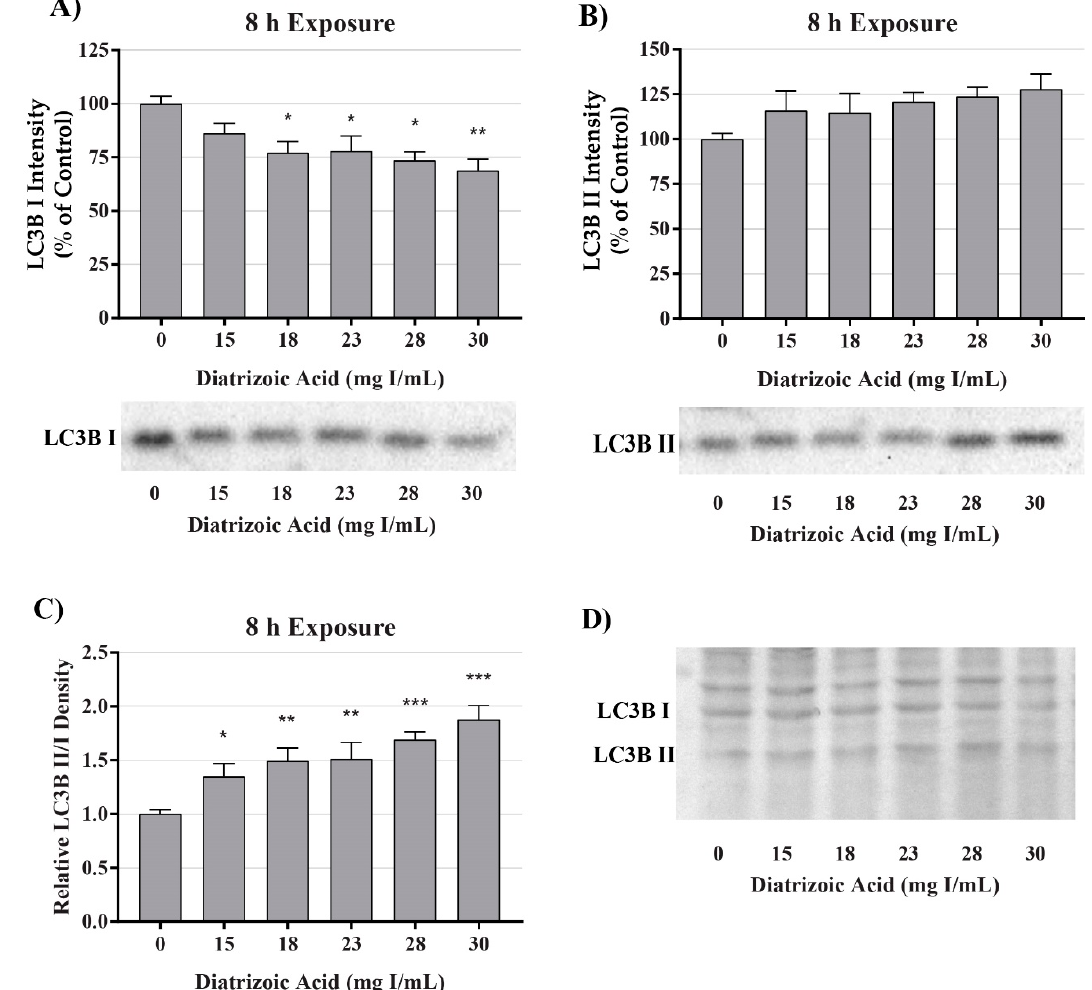
Figure 7. Diatrizoic acid effects on LC3B expression in HK-2 cells following 8 h exposure. DA induced mitophagy following 8 h exposure. Representative blots and cumulative densitometry included for LC3BI ( A ), LC3BII ( B ) exposure, and LC3BII/LC3B I ratio ( C ) following 8 h exposure to DA. Representative blot showing equivalent Memcode reversible stain for 40 µg loaded protein depicted for 8 h ( D ) exposure. Statistical di ff erence from 0 mg I / mL diatrizoic acid depicted by an asterisk (* p < 0.05, ** p < 0.01, *** p < 0.001). Values represent mean ± SEM for three independent